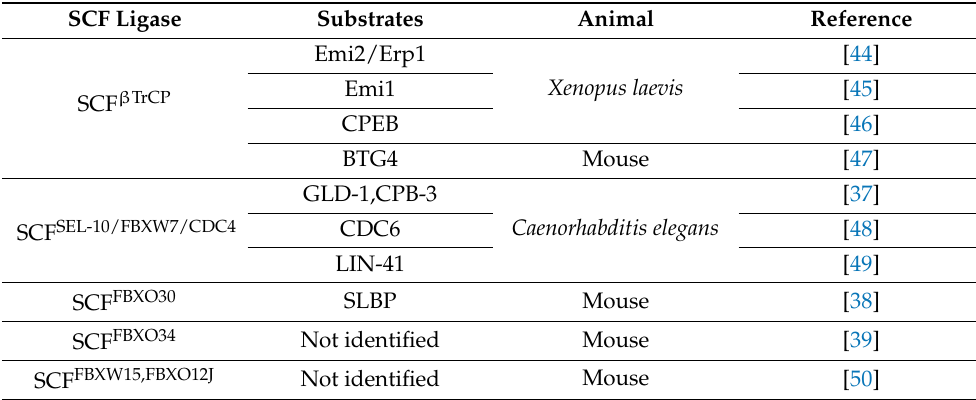
Table 1. Known SCF ligases and their substrates in oogenesis of mouse, Xenopus and C. elegans